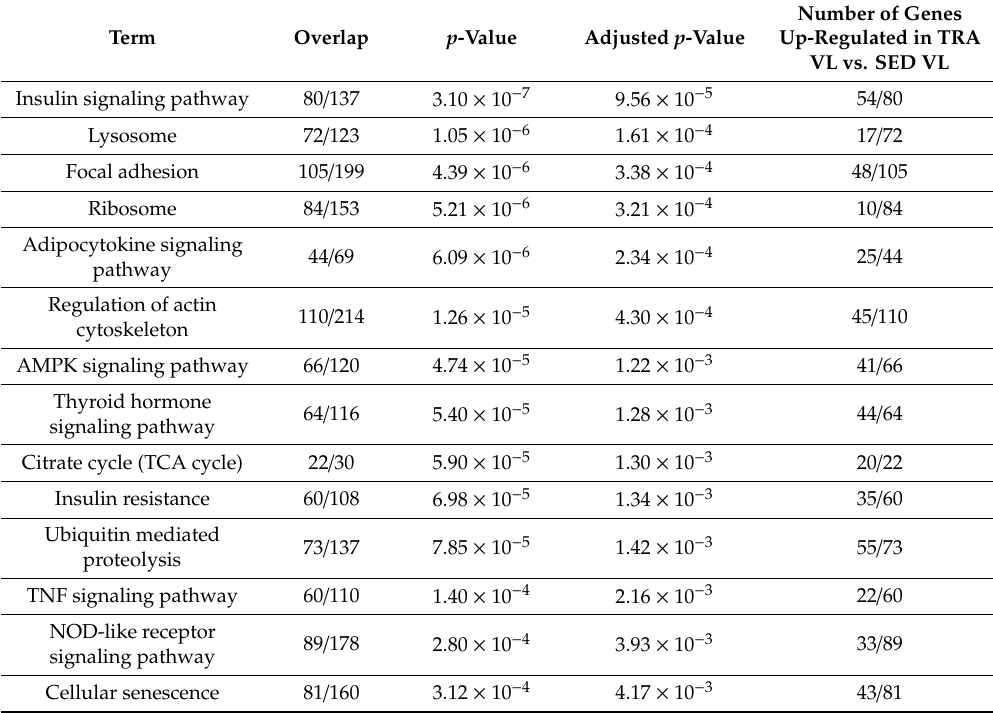
Table 7. Relevant highest scoring KEGG